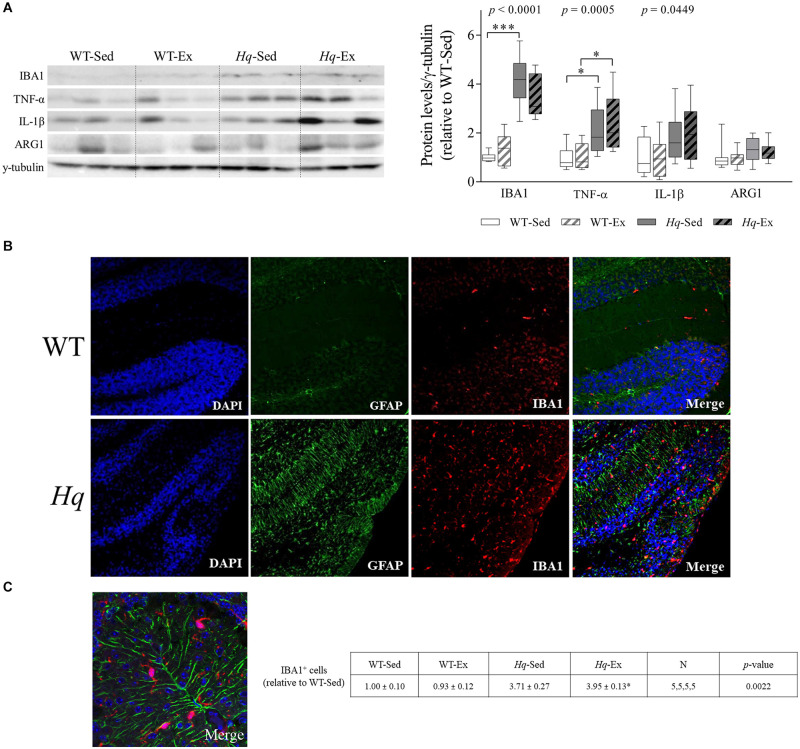
Microglial activation and polarization markers. (A) Western blot analysis of ionized calcium binding adapter molecule 1(IBA1), tumor necrosis factor α (TNF-α), interleukin 1 β (IL-1β), and arginase 1 (ARG1) in cerebellum homogenates of wild-type sedentary (WT-Sed, n = 12) and exercise-trained (WT-Ex, n = 11) mice, and of Hq sedentary (Hq-Sed, n = 11) and exercise-trained (Hq-Ex, n = 10) mice. Densitometry analysis: protein levels were normalized to γ-tubulin levels; data (median, interquartile range, and min and max values) are expressed relative to levels in the WT-Sed group. Significant p-values for the group effect (Kruskal-Wallis test) are shown above the corresponding boxes. Symbols for significant differences in post hoc pairwise comparisons: ∗p < 0.05; ∗∗∗p < 0.001 for Hq-Sed vs. WT-Sed, and Hq-Ex vs. WT-Ex. (B) Immunofluorescence analysis of cerebellar cortex for detection of GFAP (green), and IBA1 (red), and nuclei (blue), and merged images in representative sedentary WT and Hq mice (10×). Analyses were performed in 5 animals for each experimental group, 1 slide per animal. Only representative WT-Sed and Hq-Sed images are shown for simplicity purposes, due to absence of training-induced effect. (C) Higher magnification image of a representative sedentary Hq mouse showing activated microglial cells in both granule and molecular layers (63×).